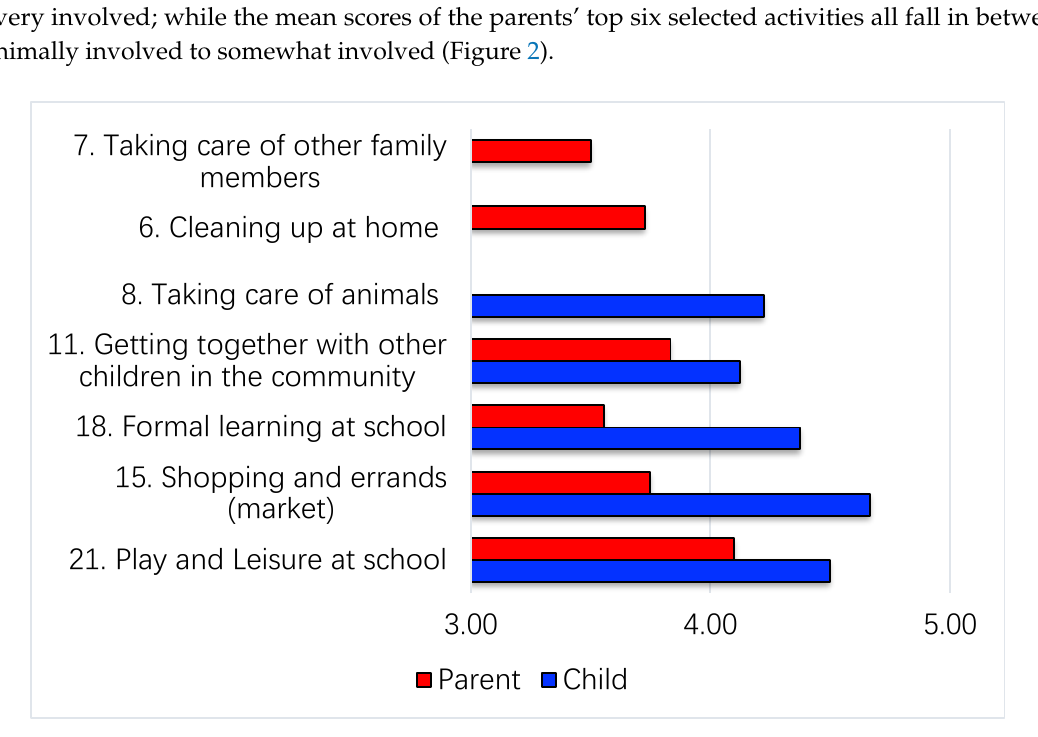
Figure 2. Mean scores for level of involvement of top 5 or 6 activities of the PMP-C selected and rated by children and parents. Level of involvement scoring: 5: Very involved, 4: Somewhat involved, 3: Minimally involved, 2: Not applicable, 1: Unsure or no answer. Note: PMP-C = Chinese version of Picture My